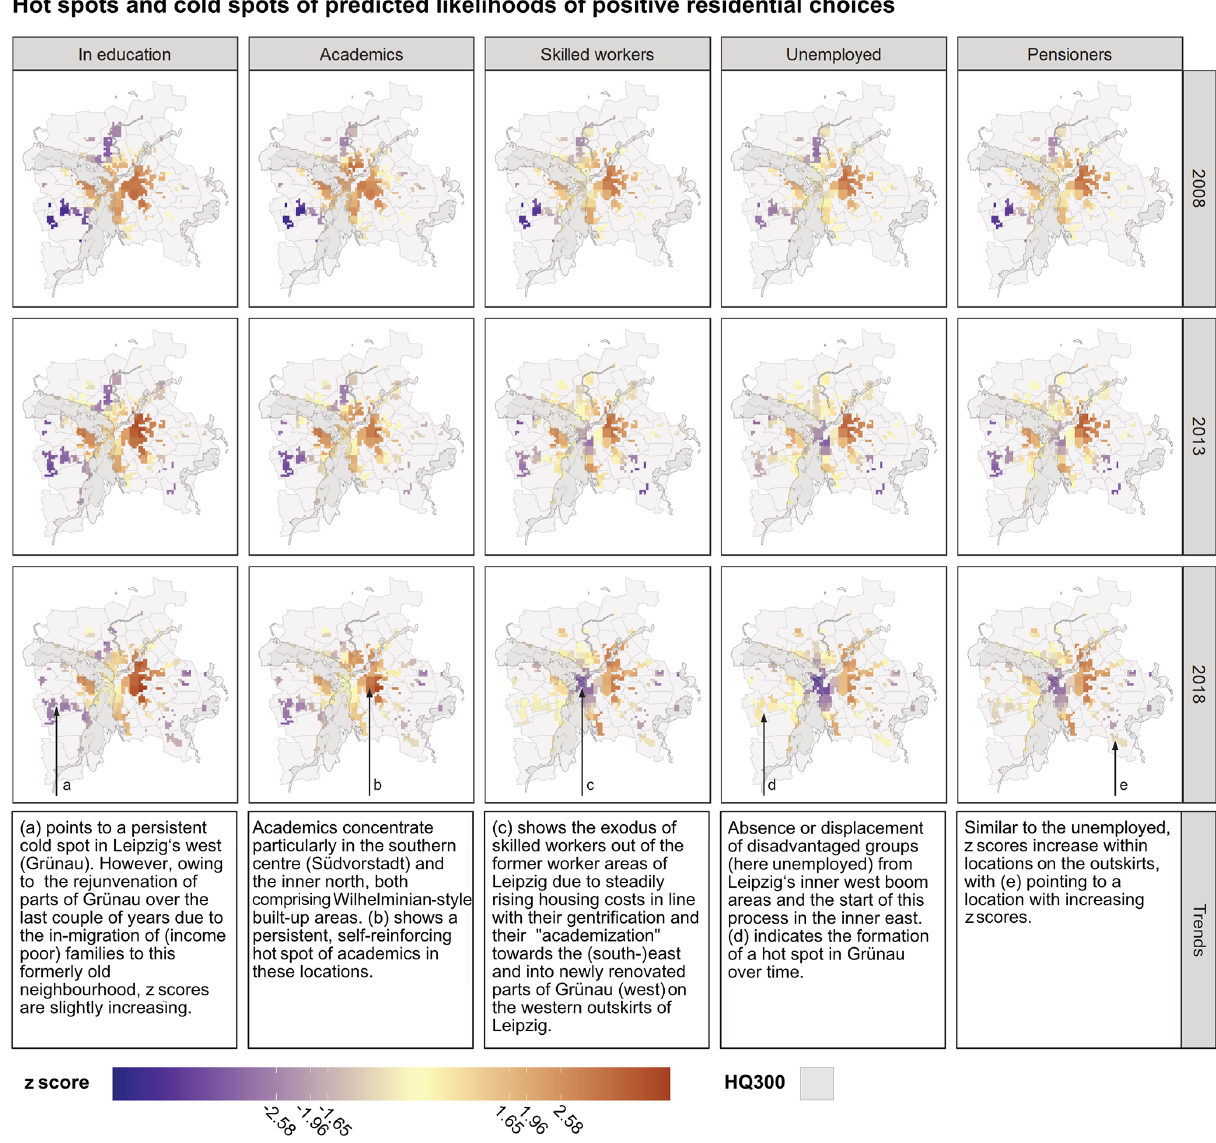
Figure 5. Map of local G* z scores indicating likely hot spots and cold spots of the predicted likelihoods of positive residential choices per socioeconomic group for the time steps 2008, 2013, and 2018. Arrows indicate exemplary locations of persisting cold spots (a) , reinforcing hot spots (b) , hot spots turning into cold spots (c) , and cold spots turning into hot spots for unemployed (d) or elderly persons (e) . The map furthermore shows the area potentially affected by a 1-in-300-year flood event